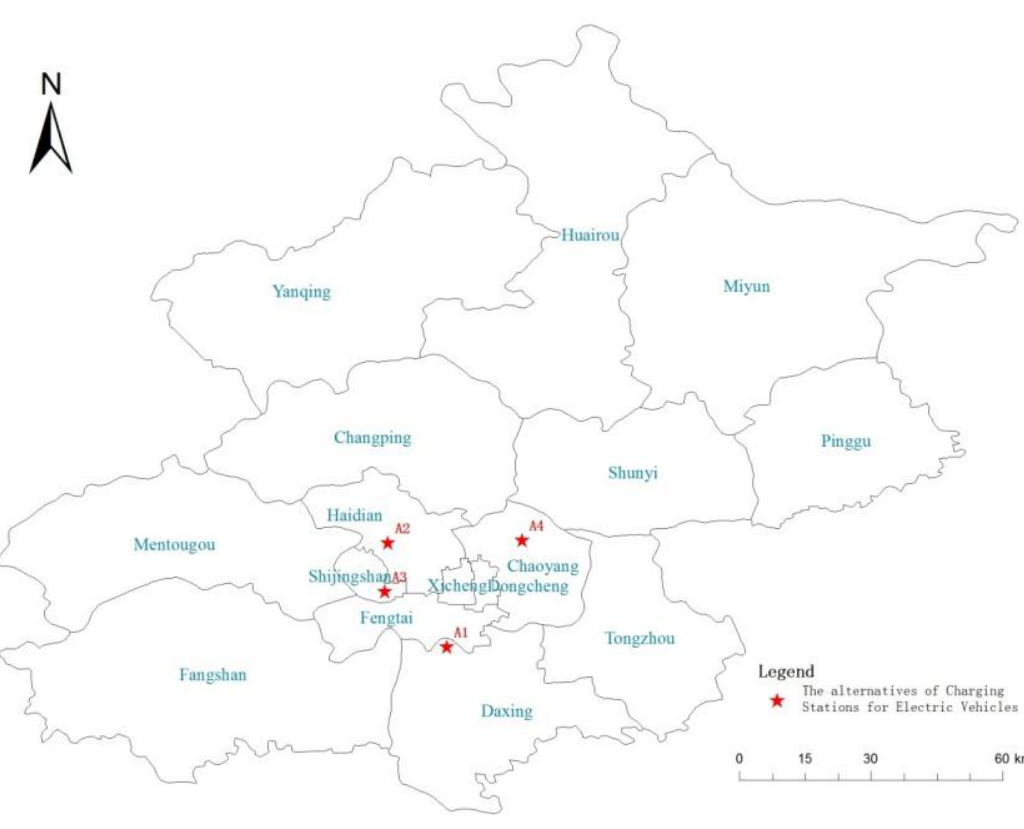
Figure 2. The geographical positions of the potential sites. Table 4. Mutual influence concerns of the factors.